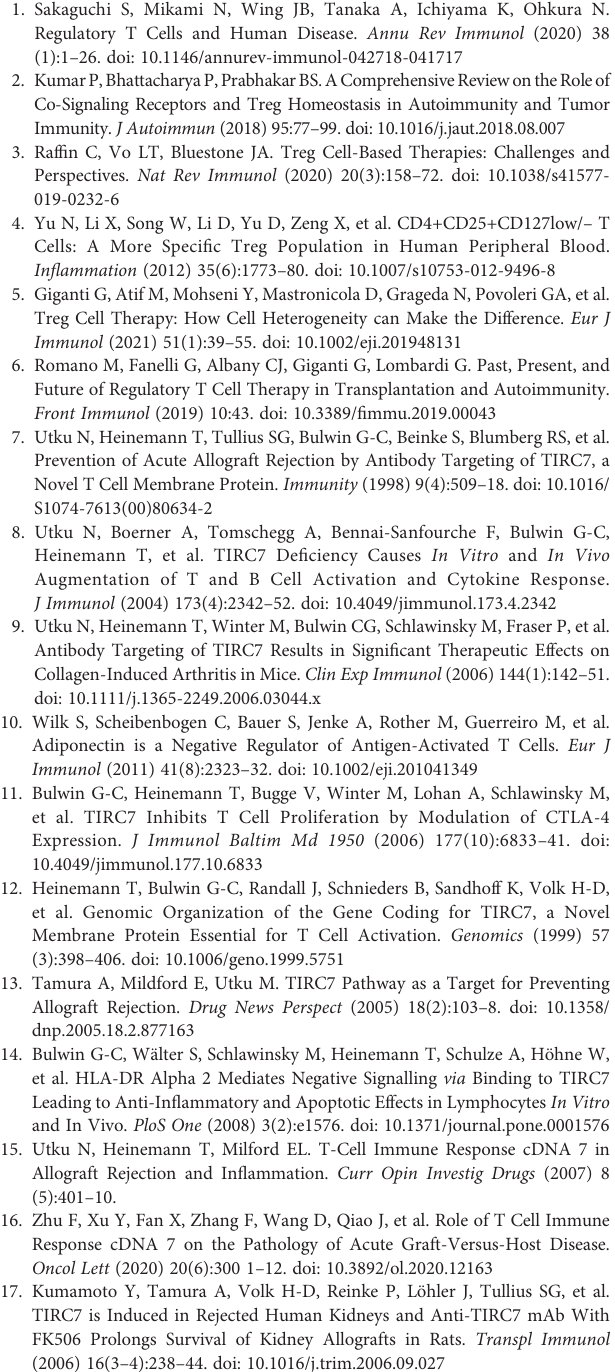
Supplementary Figure 2 | Overlaid histograms for marker expression. (A) Shows overlaid histograms with marker expression on IR1 (red) in comparison to IR1neg (blue) Treg after 72h IL-2 incubation (8 healthy volunteers). (B) Shows the mean fl uorescent intensity ofmarkers measured onTreg after 72h IL-2 incubation (8healthy